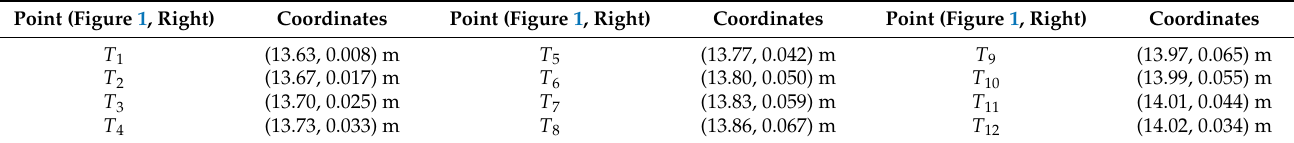
Table 1. Elevation coordinates of the barrier.